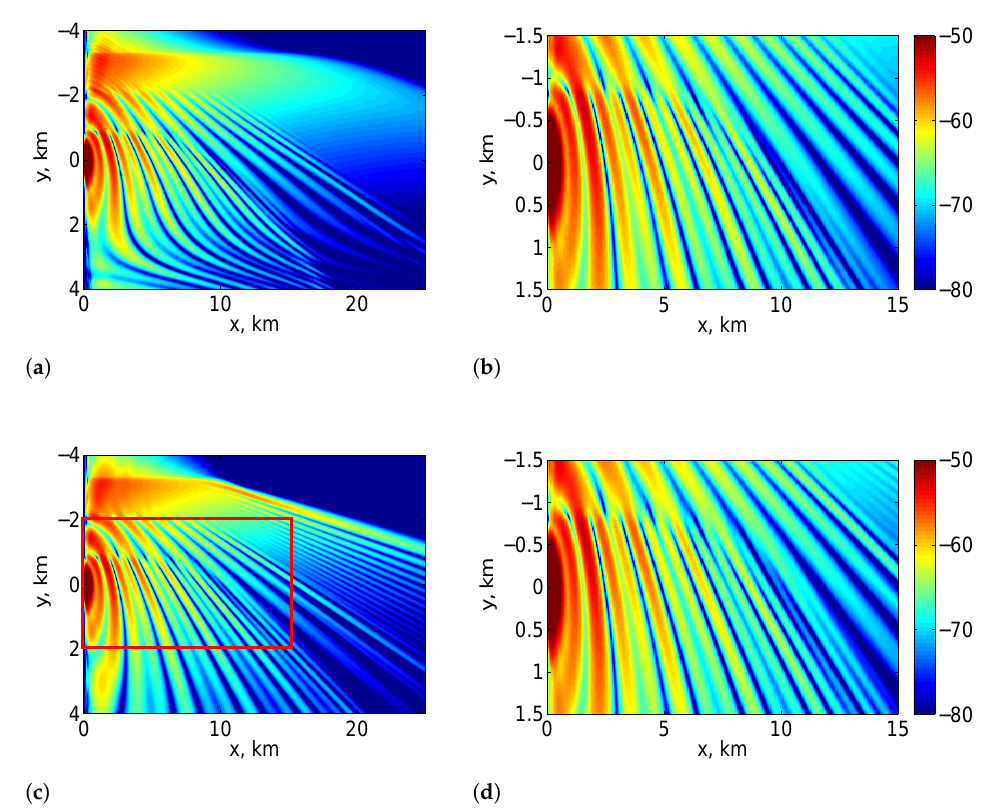
Figure 5. The field at z = z r computed using eigenvalues and eigenfunctions obtained by the 3rd-order perturbation formulae ( a , b ) and by solving the Sturm–Liouville problem (3) for each h ( c , d